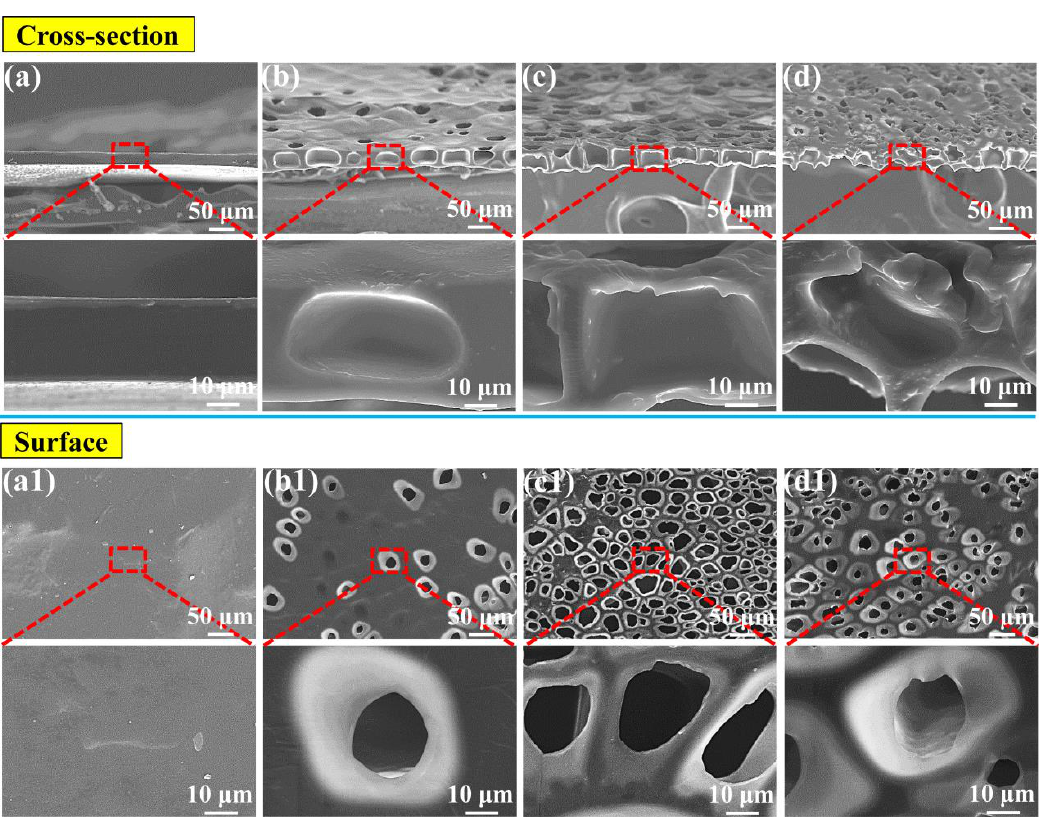
Figure 5. SEM images of the TPU perforated membrane saturated under 1.5 MPa: ( a ) the cross-section and ( a1 ) the corresponding surface foamed at 110 ◦ C. Following similar principle, ( b , b1 ), ( c , c1 ), as well as ( d , d1 ) foamed at 120, 130 and 140 ◦ C, respectively.